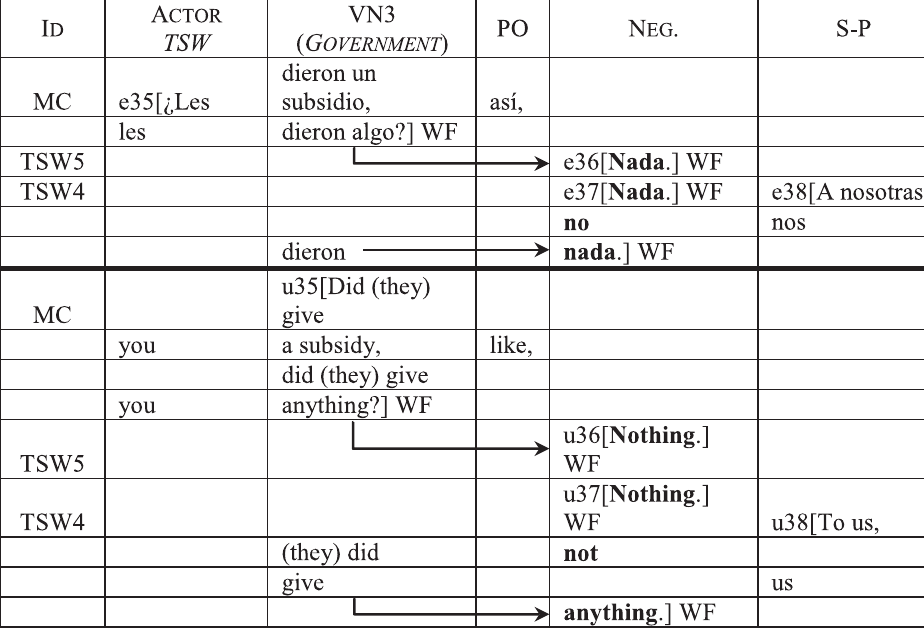
TABLE 12 | The Negation category in the transgender sex workers ’